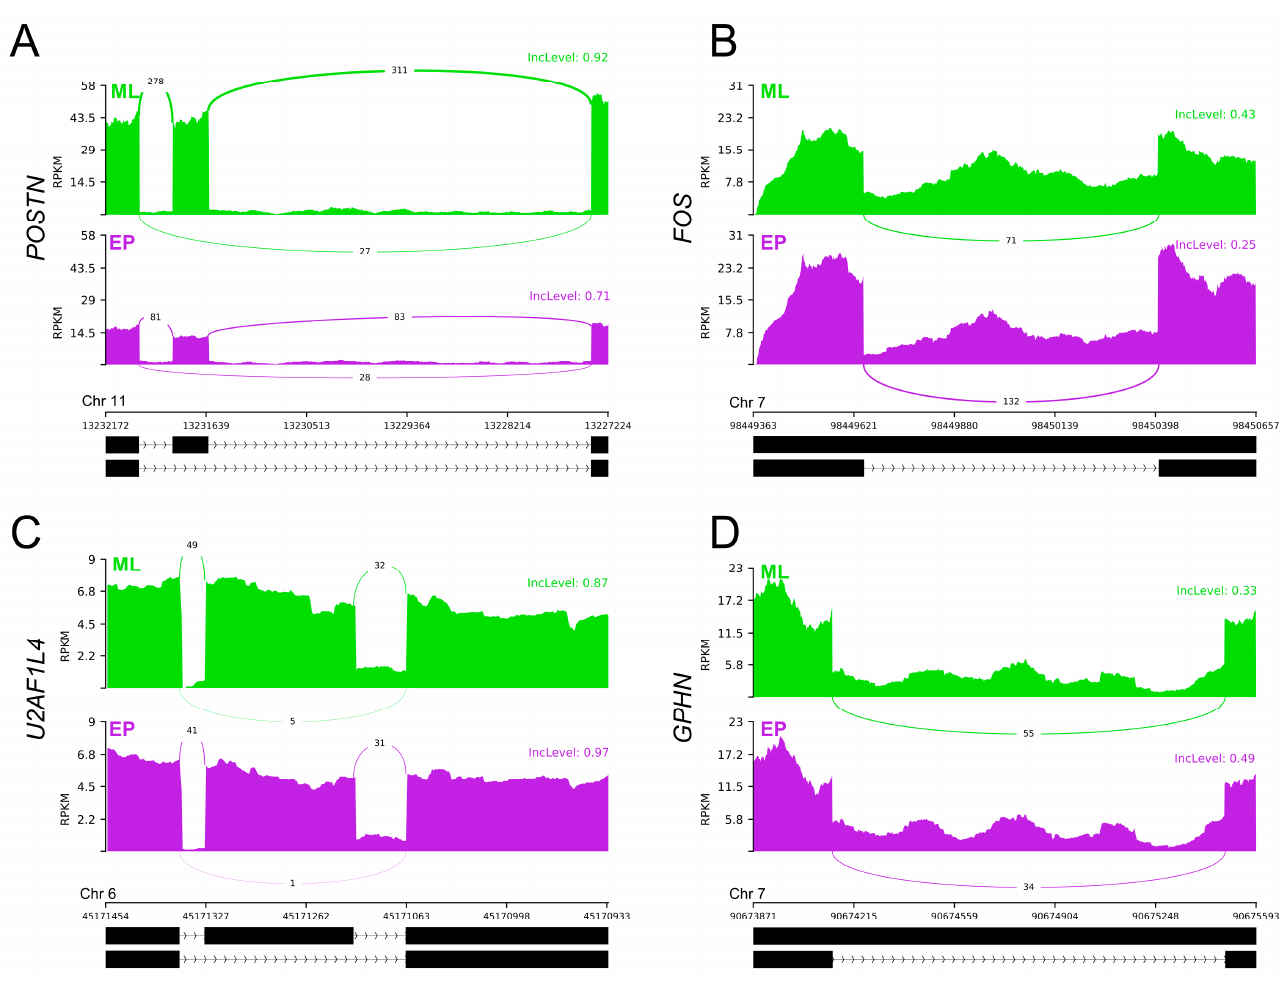
Figure 4. Sashimi plot visualizing the detected coverage of RNA-Seq reads on the reference genome and the average values of reads combining distant genome fragments (black blocks underneath the graphs) in EP and ML groups. Displayed fragments of ( A ) POSTN , ( B ) FOS , ( C ) U2AF1L4 and ( D ) GPHN genes were classified as statistically significant differentiated alternative splicing